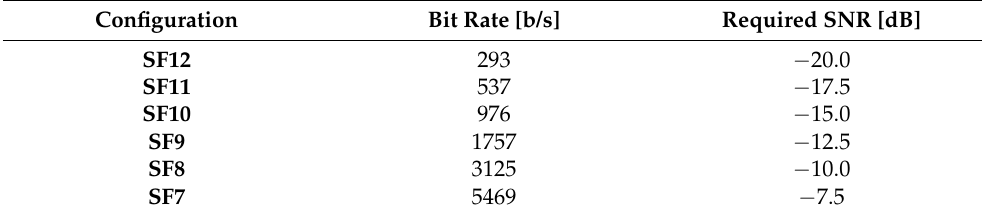
Table 1. LoRaWAN configuration table [16].